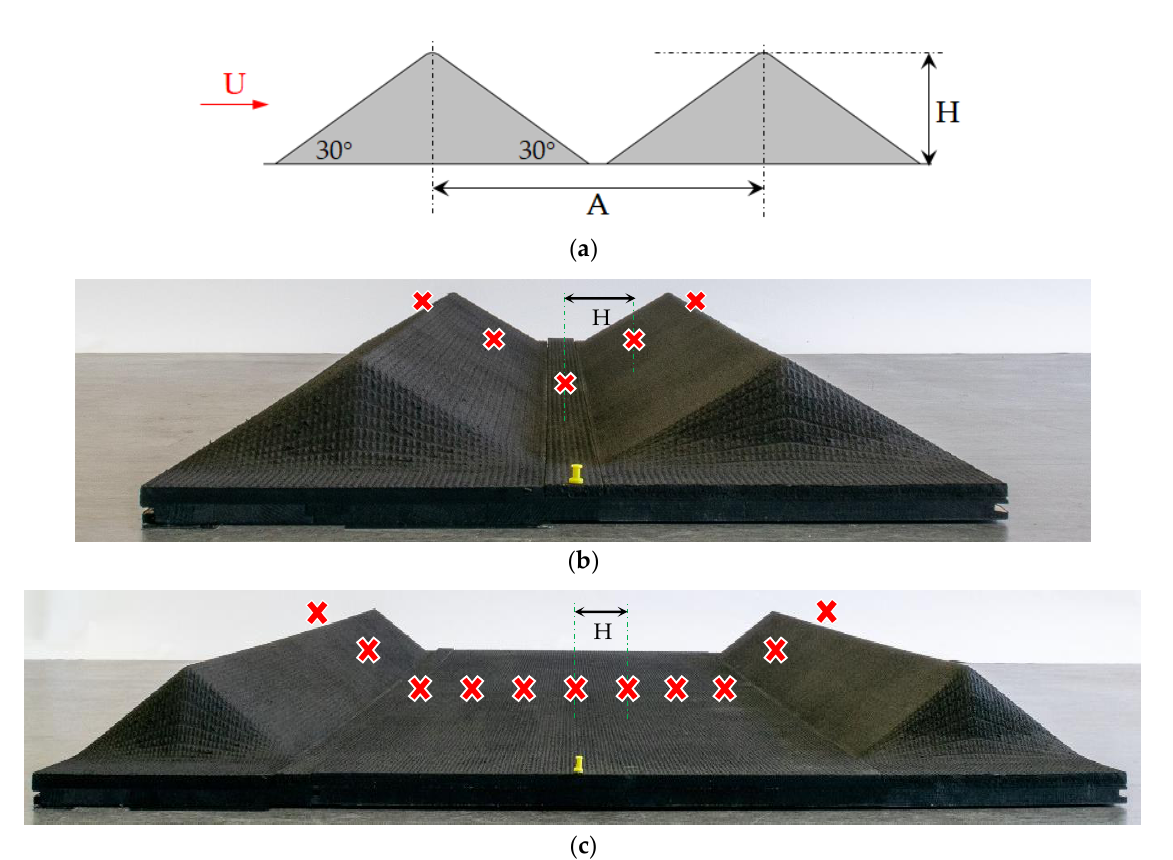
Figure 2. ( a ) Schematic of the idealized valleys of the present experiments, where the angles correspond to the inclinations of the ridge slopes, A represents the valley width, H corresponds to the valley depth, and U the longitudinal flow direction; ( b ) lateral view of the smallest width valley model (A = 4H); ( c ) lateral view of the largest width valley model (A = 12H). The yellow pin in ( b , c ) marks the approximate midpoints of the valleys, and the X symbolizes the approximate measurement locations in the horizontal plane.